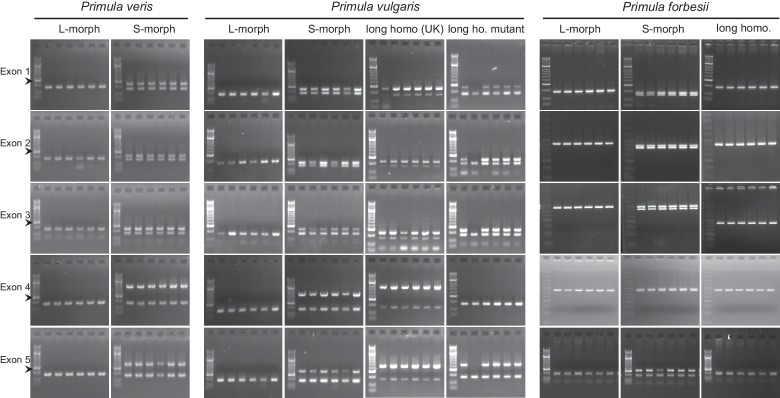
Co-segregation of CYP734A50 with the style phenotype.PCR-genotyping of individuals with the indicated phenotypes of P. veris (left), P. vulgaris (middle) and P. forbesii (right). Multiplex PCR amplified CYP734A50 and ITS as an internal control. Arrowhead marks 300 bp band in DNA-size standard.